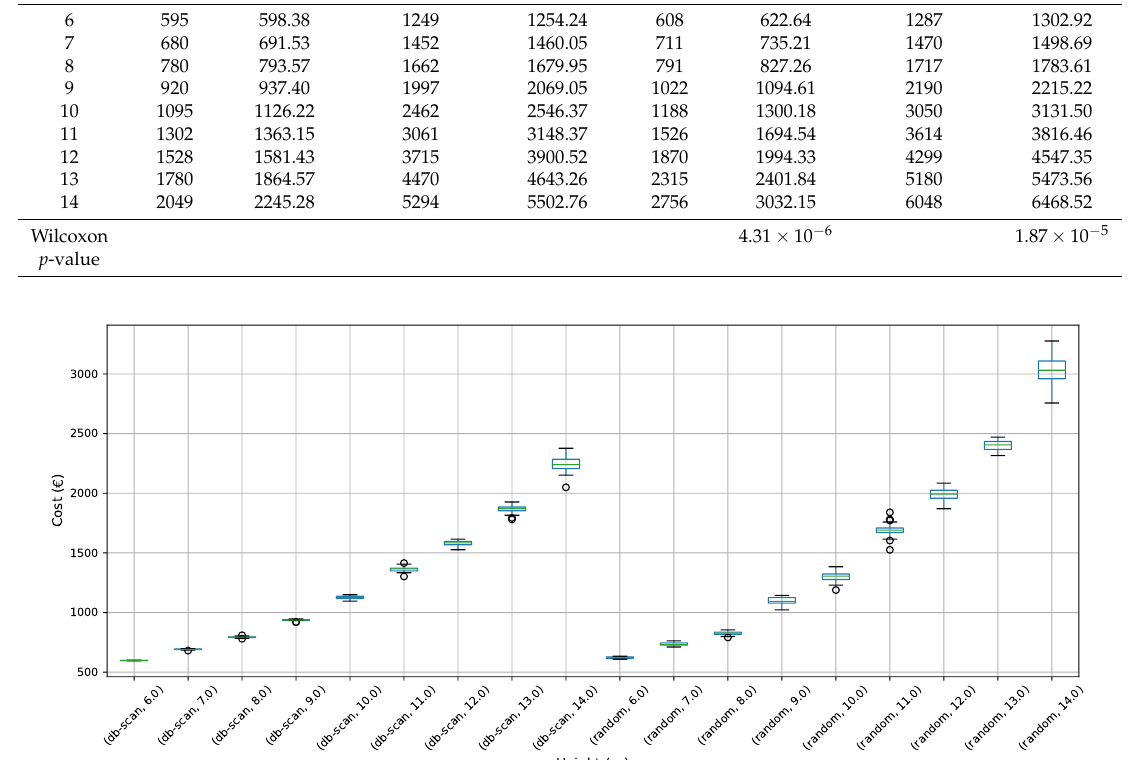
Figure 7. Cost box-plots, comparison between db-scan and random operators.